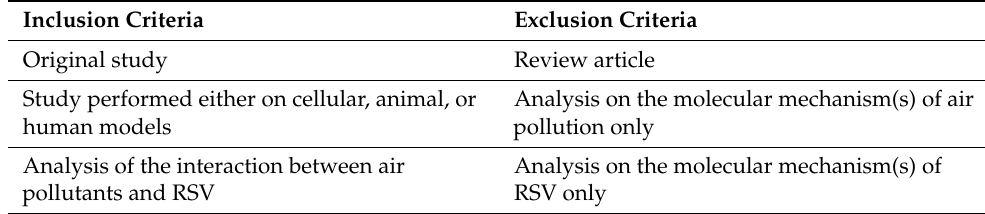
Table 1. Eligibility criteria for the study